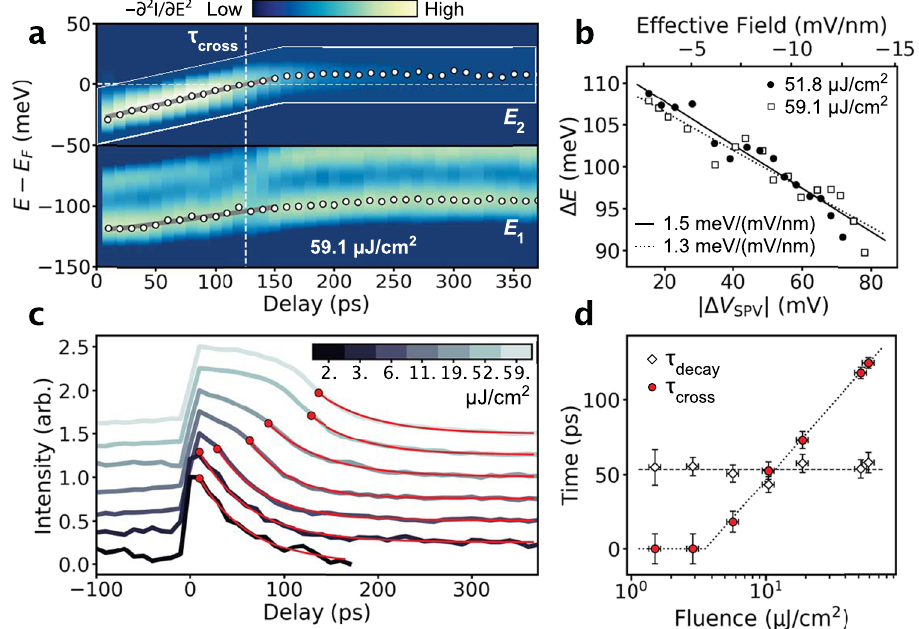
Fig. 3 Quasi-equilibrium charge and ultrafast intersubband-gap control. a ∂ 2 / ∂ E 2 spectra of QW1 and QW2 band bottoms as a function of delay. The band bottom positions are marked by black-lined white dots demonstrating a near-linear recovery up to the moment E 2 crosses E F , fl uences (51.8 and 59.1 μ J cm − 2 ). The τ cross . b The intersubband-gap as a function of the SPV determined at each delay for the two highest effective fi eld on the quantum well system is extrapolated from the average best fi t line and the triangular-well approximation. c Integrated spectral intensity of the QW2 band bottom using integration window in a over a large fl uence range. E F crossing time, ( τ cross ), + 10 ps is used as a cutoff (minimum set at 10 ps) for exponential fi ts (red). d QW2 decay rate, τ decay , (black open diamonds) and τ cross (red dots) as a function of maximum SPV at each fl uence (and extrapolated effective fi eld on QWs) indicating that the lifetime of QW2 states above E F is fi xed but quasi- equilibrium lifetime is set by peak fi eld strength. d y axis error bars are from fi t covariance in c ( τ decay ) and linear fi t in Supplementary Fig. 9 ( τ cross ), fl uence error is 10%